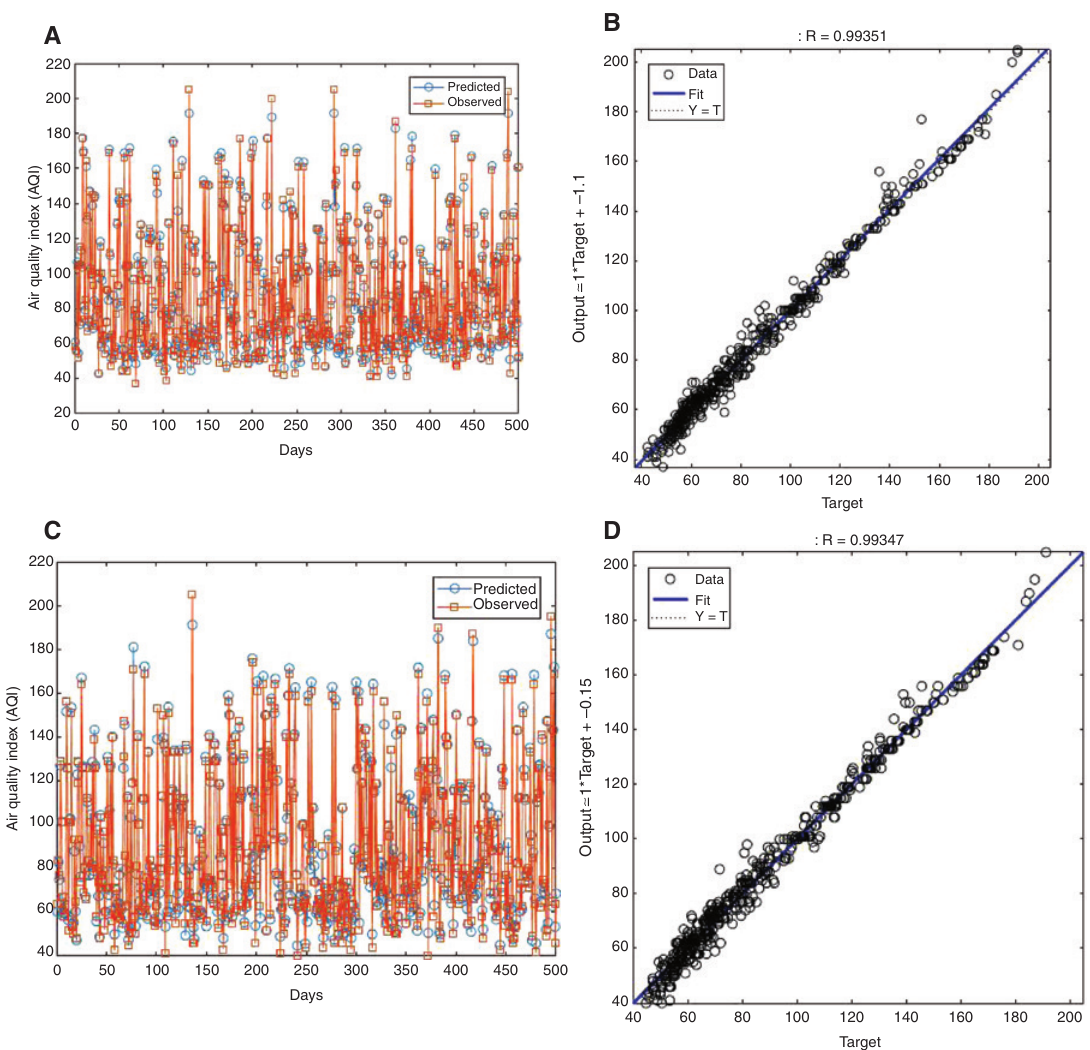
Figure 4: SVR Ensemble of Neural Network Predictors: (A) Testing Plot for Houston, (B) Regression Plot for Houston, (C) Testing Plot for Los Angeles, and (D) Regression Plot for Los